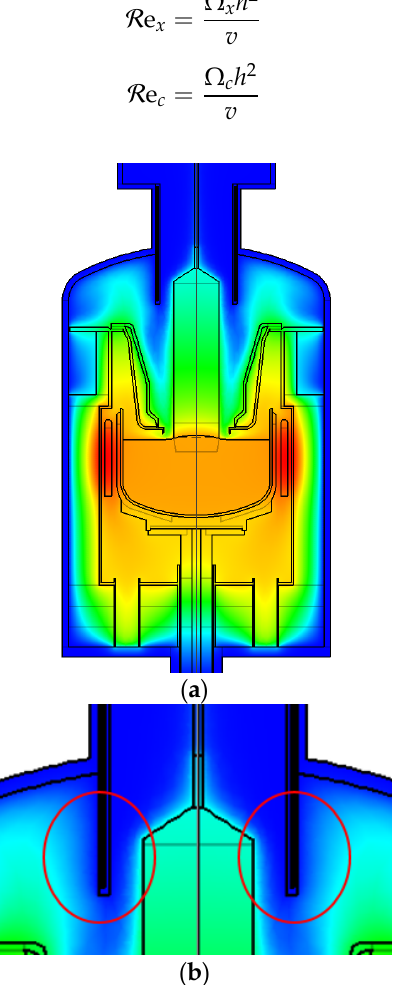
Figure 1. Geometry of Czochralski process ( a ), basic process of cooling system ( b ) from Crystal Growth Simulation.